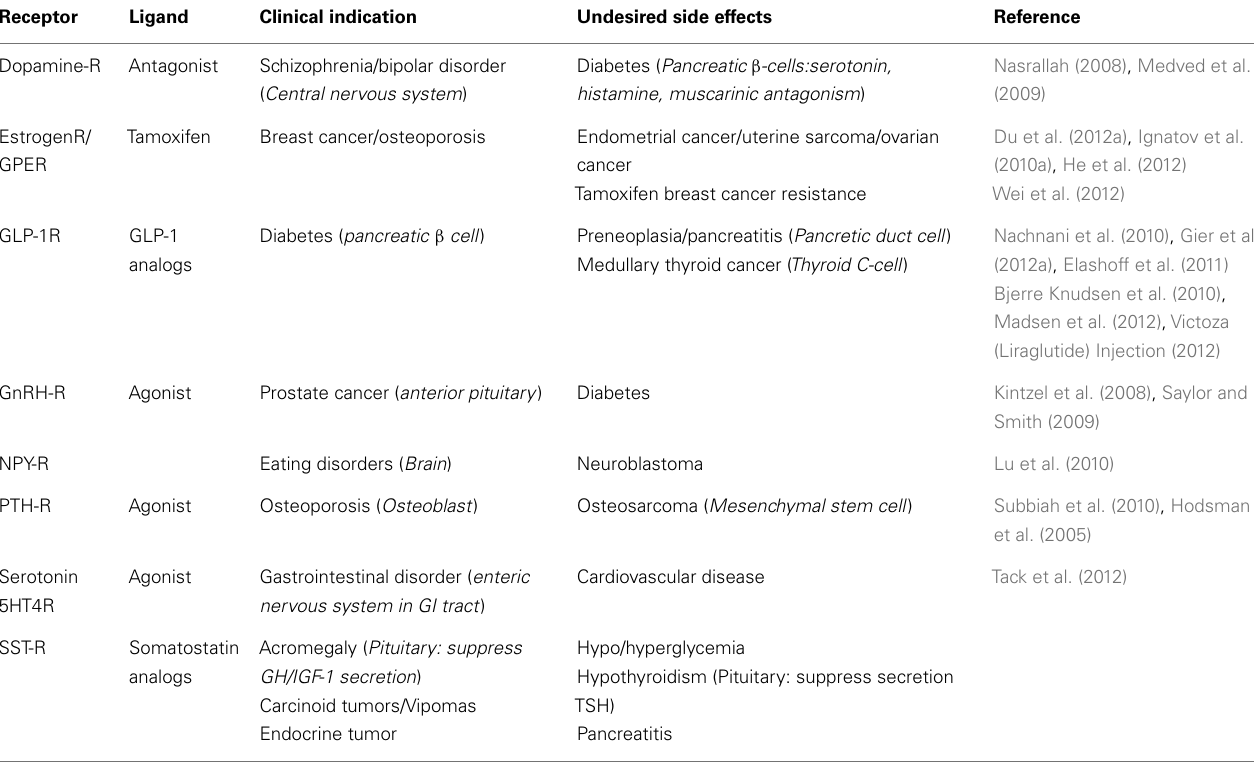
Table 1 | Examples of ligands used for clinical indication in endocrinology with undesired side